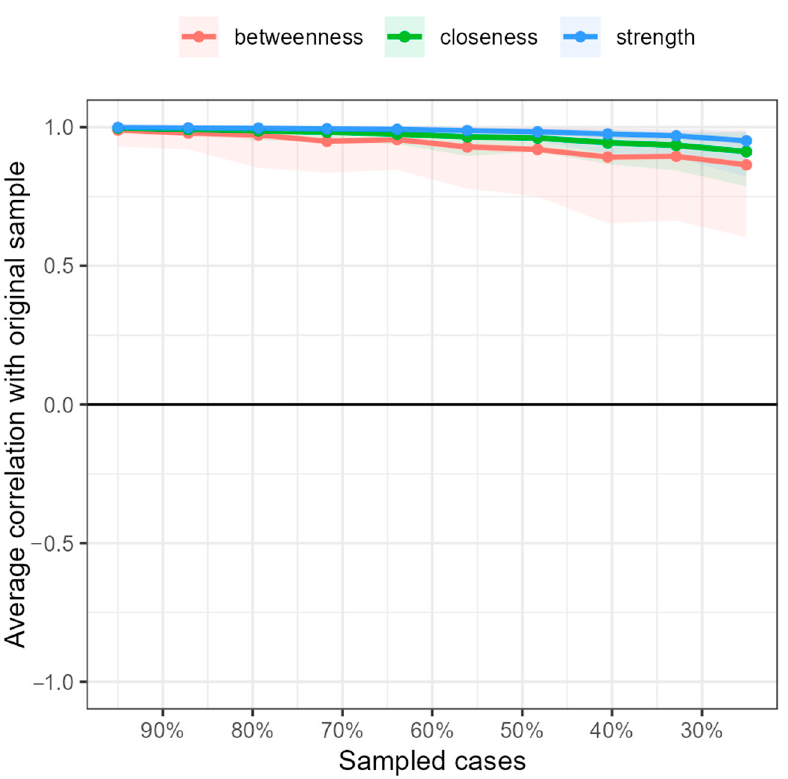
Figure A7. Stability of the ‘year’ moment network centrality indices with case dropping bootstrap subset.